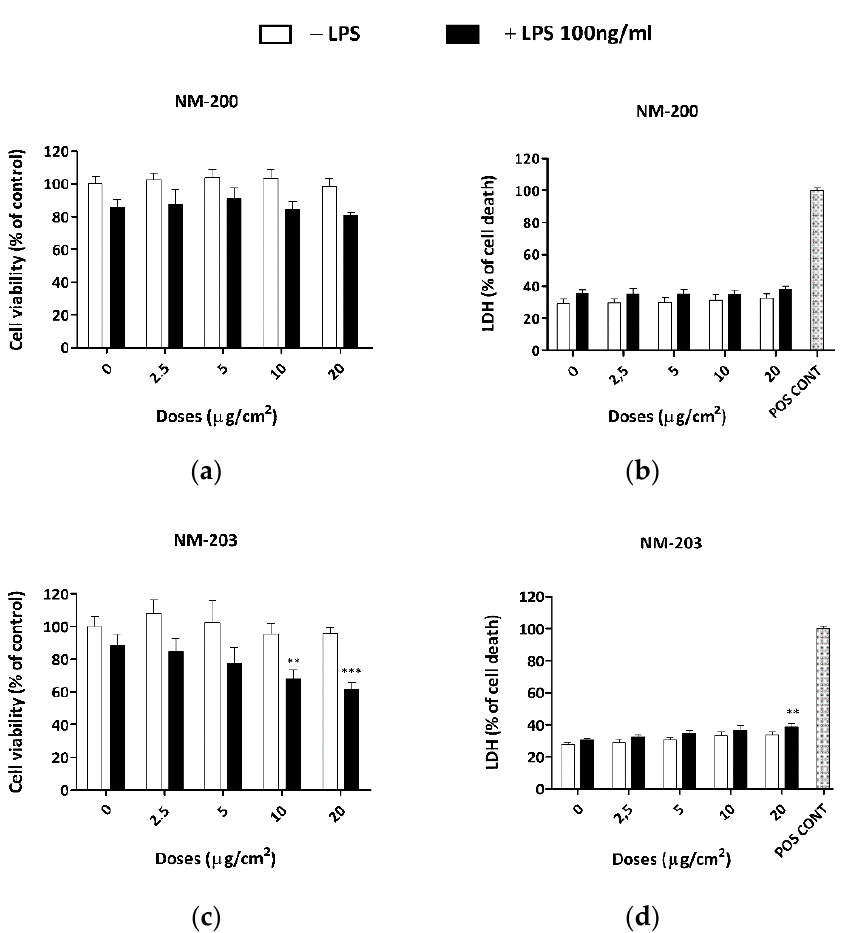
Figure 1. Effects of NM-200 and NM-203 on cell viability and cytotoxicity in THP-1 cultures. PMA-differentiated THP-1 cells were treated for 48 h with ( a , c ) NM-200 or ( b , d ) NM-203 (range 2.5–20 μ g/cm 2 ) in the absence (empty bars) or in the presence of LPS (100 ng/mL, solid bars) in the last 24 h of incubation. At the end of the experimental treatments, the cell viability was determined by ( a , b ) the resazurin method, while ( c , d ) the cytotoxicity was assessed from the LDH activity in the medium. Data are means of ( a , b ) five or ( c , d ) four independent determinations ± SD and are expressed as % of the control (no treatment) for ( a , b ), or as % of the positive control for cell death ( c , d ). The experiments were performed three times with similar results. ** p < 0.01; *** p < 0.001 vs. cells treated with LPS alone, one-way ANOVA. ‘Pos cont’, positive